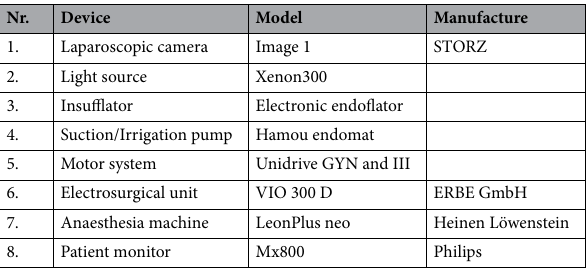
Table 3. Medical devices included in this study and their models and manufacturers.